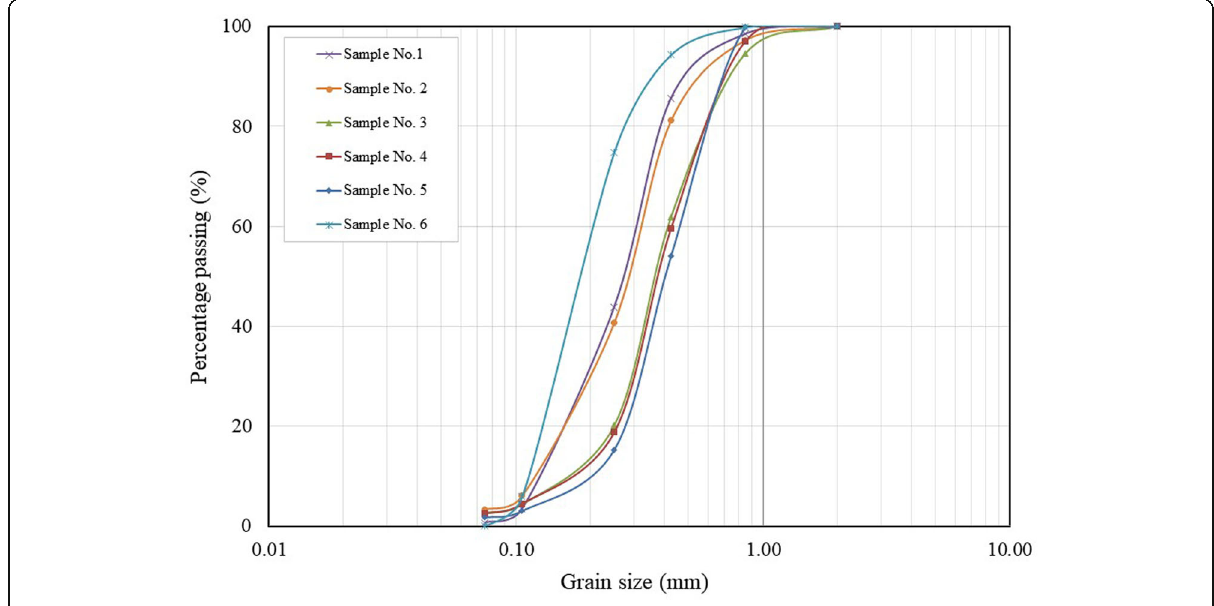
Fig. 3 Grain size distribution curves of samples used in experiments